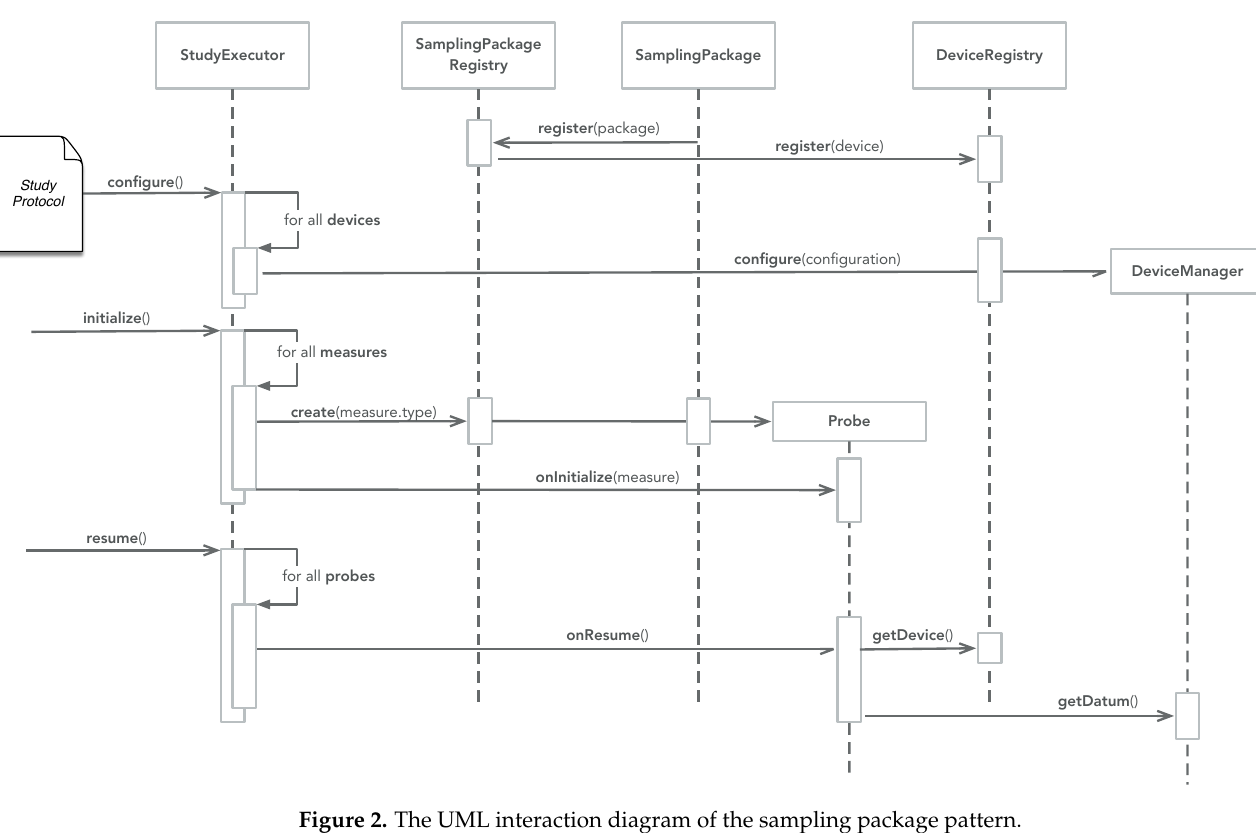
Figure 2. The UML interaction diagram of the sampling package